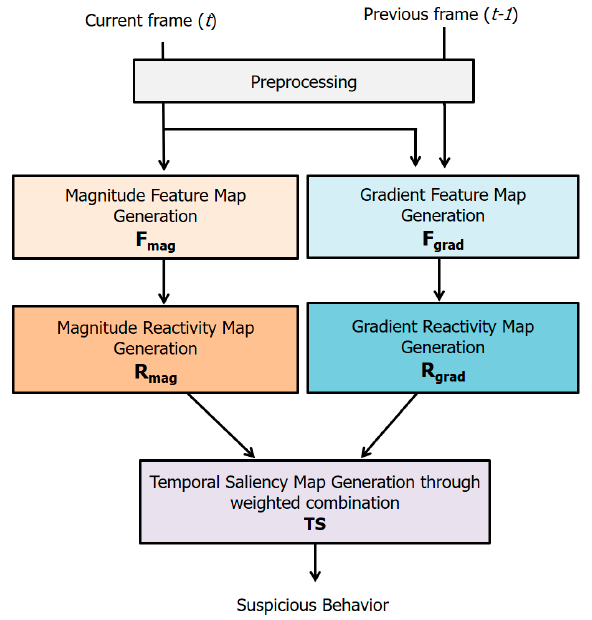
Figure 1. The overall process of the proposed method.